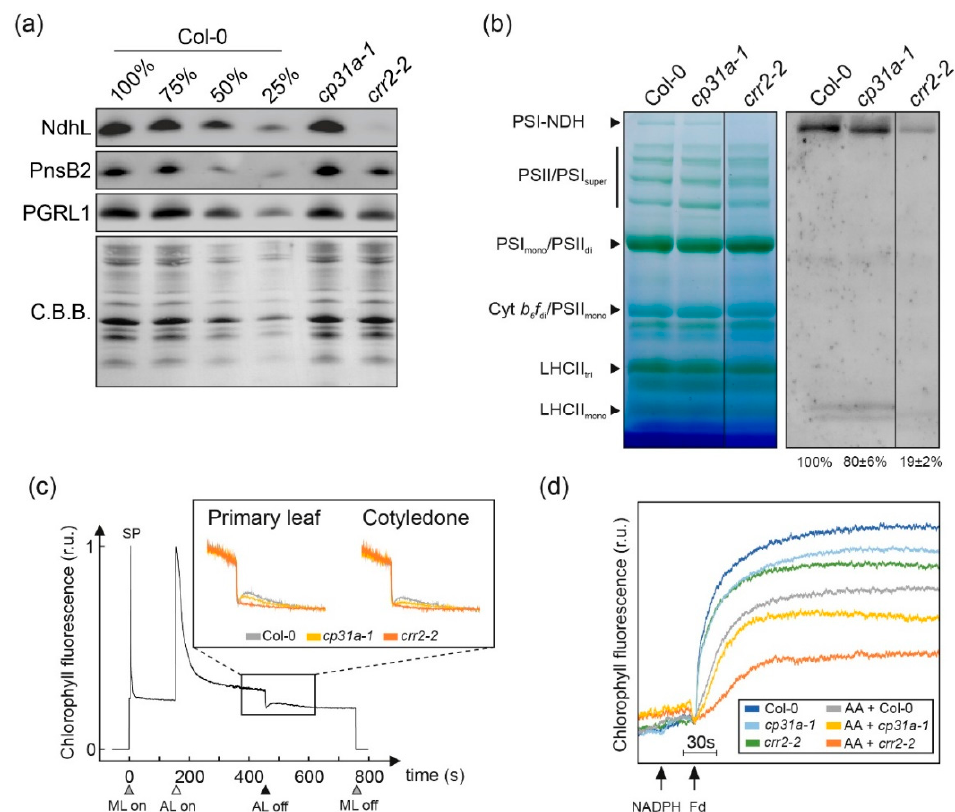
Figure 3. Analysis of NDH complex accumulation and activity in cp31a mutants. ( a ) Thylakoid membranes were isolated from wild-type (Col-0), cp31a and crr2 plants. Proteins samples adjusted to 2.5 µg chlorophyll were size-fractionated on SDS-PAGEs, transferred to polyvinylidene difluoride membranes (PVDF) and probed with antibodies raised against NdhL, PnsB2 and PGRL1. As loading control, PVDF membranes were stained with Coomassie Brilliant Blue G-250 (C.B.B.). ( b ) Thylakoid membranes from wild-type (Col-0), cp31a and crr2 plants corresponding to 80 µg chlorophyll were solubilized with 1% [ w / v ] n -dodecyl β -D-maltoside and fractionated by 4 to 12% BN-PAGE. The major protein complexes were assigned to individual bands as described [26]. Denatured protein